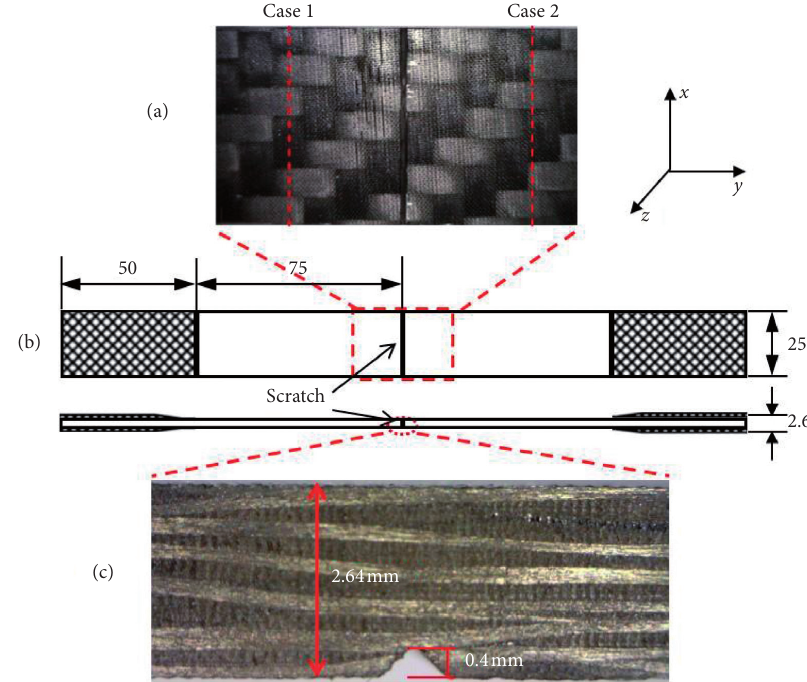
Figure 1: Geometry and dimensions of a representative sample with a 25 mm scratch length.